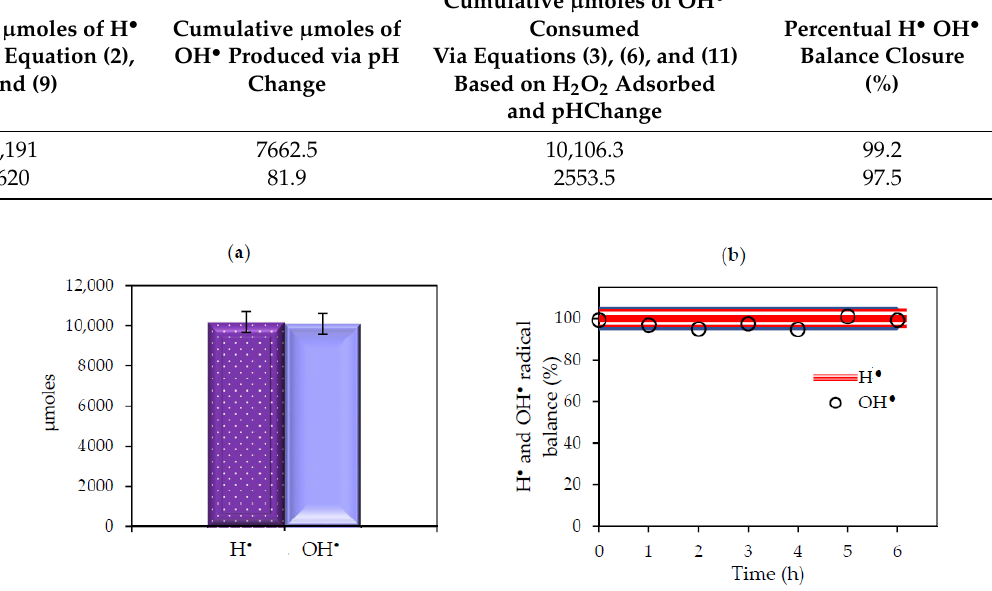
Figure 11. ( a ) μ moles of OH • and H • radicals Formed after 6 h of photocatalytic hydrogen production under near-UV light, and ( b ) percentual H • and H • μ moles balances at different irradiation times under near-UV Light. The 95% confidence and prediction intervals are reported in red and blue, respectively.